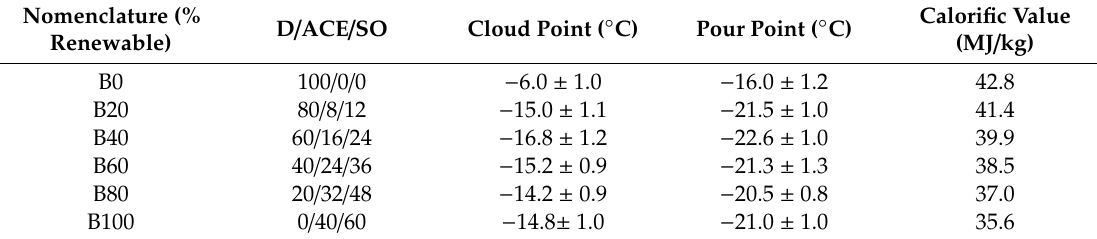
Table 2. Cloud point, pour point and calorific value of diesel/acetone/sunflower oil blends, obtained by adding different amounts of fossil diesel to acetone/sunflower oil double mixture, containing 40% acetone. Errors are always calculated from the average of three measurements.